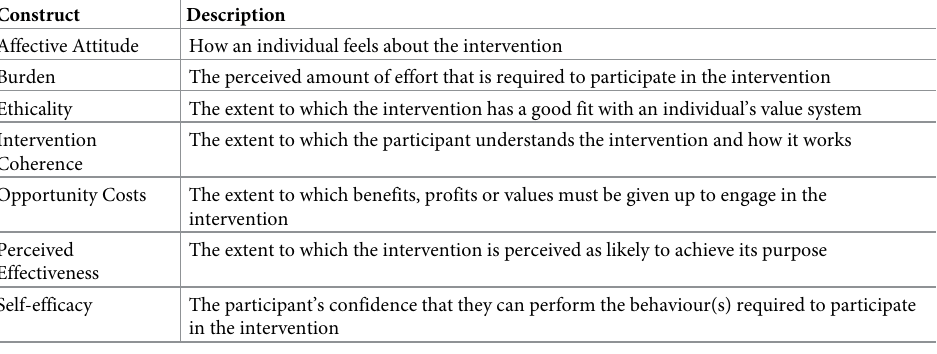
Table 2. Constructs and descriptions of the Theoretical Framework of